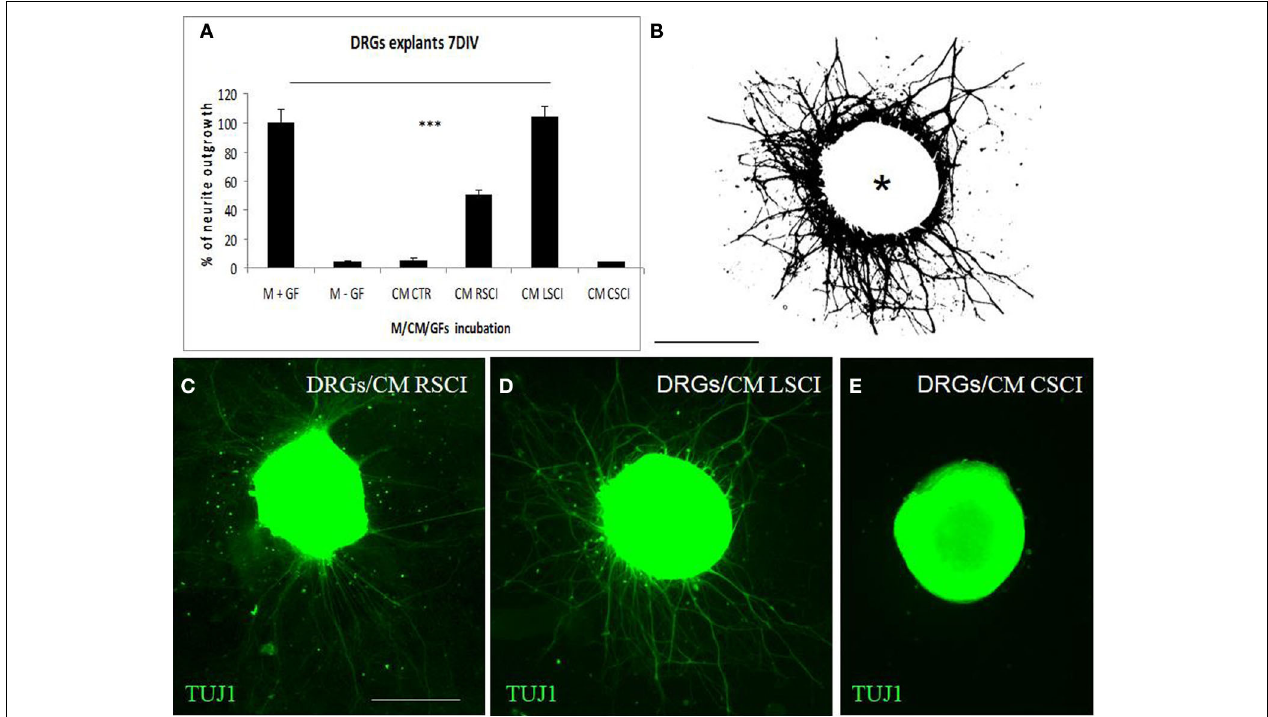
FIGURE 3 | Quantification of DRG explant neurite outgrowth in response to culture media. M + GF (DMEM + growth factors), M-GF (DMEM without growth factors), and conditioned media: CM CTR (control spinal cord), after SCI: CM RSCI (rostral segment), CM LSCI (lesioned segment), CM CSC (caudal segment) (A) . The image of TUJ1 stained